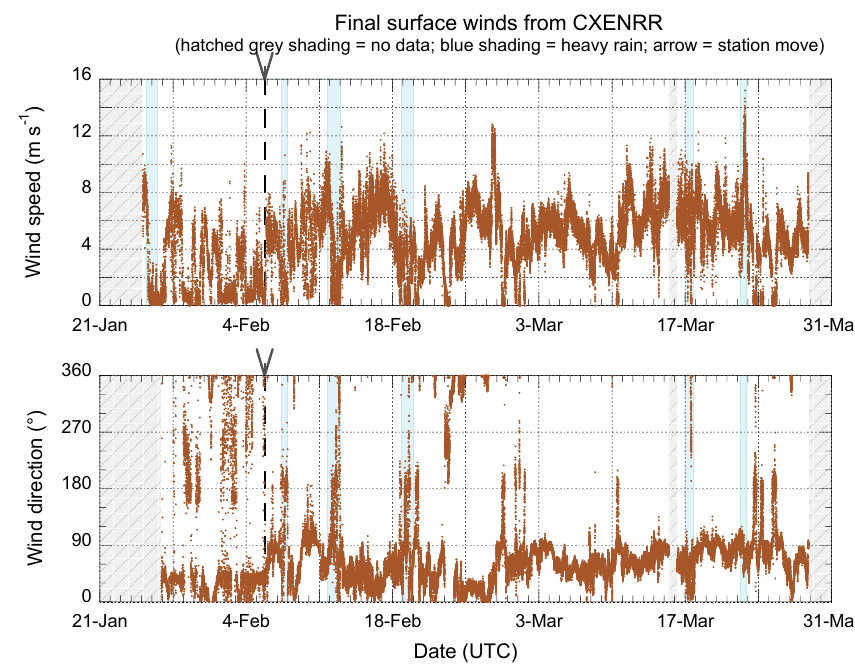
Figure 10. The corrected surface winds from the Kiritimati Island site. Pale blue shading indicates the six largest rainfall events (cf. Fig. 8), while hatched grey shading indicates times with no data.